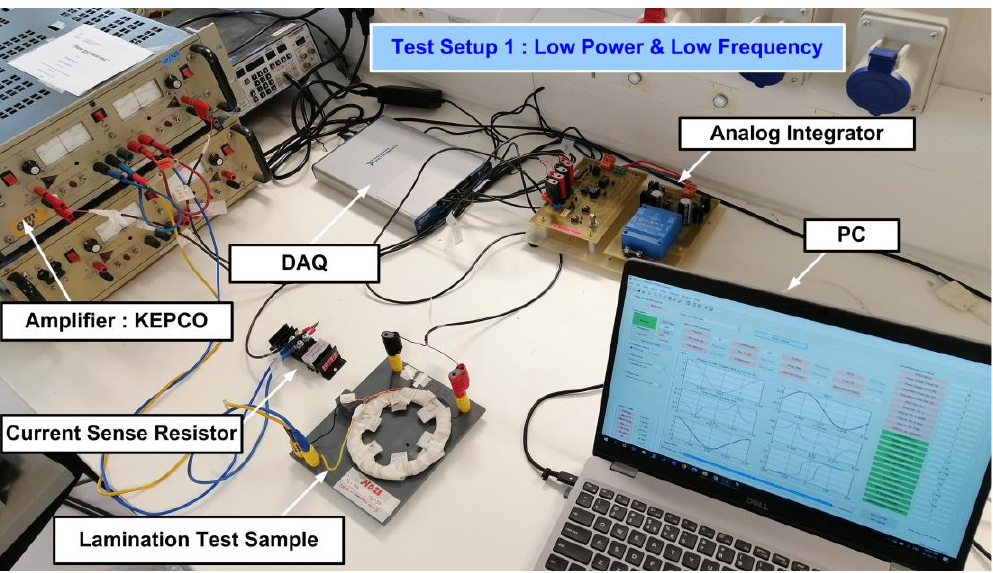
Figure 3. Experimental setup for individual laminations of the SRM at low power and low fre- quency.